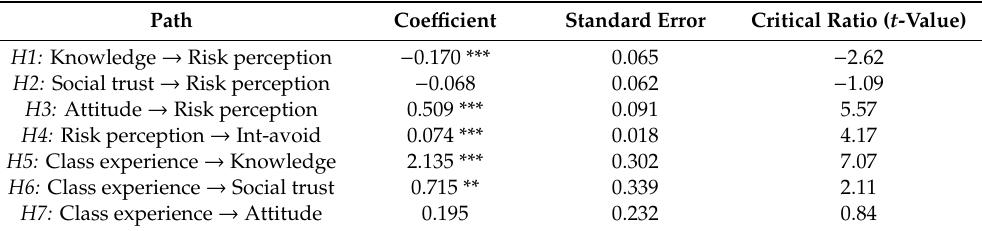
Table 4. Estimation results of structural equation model.